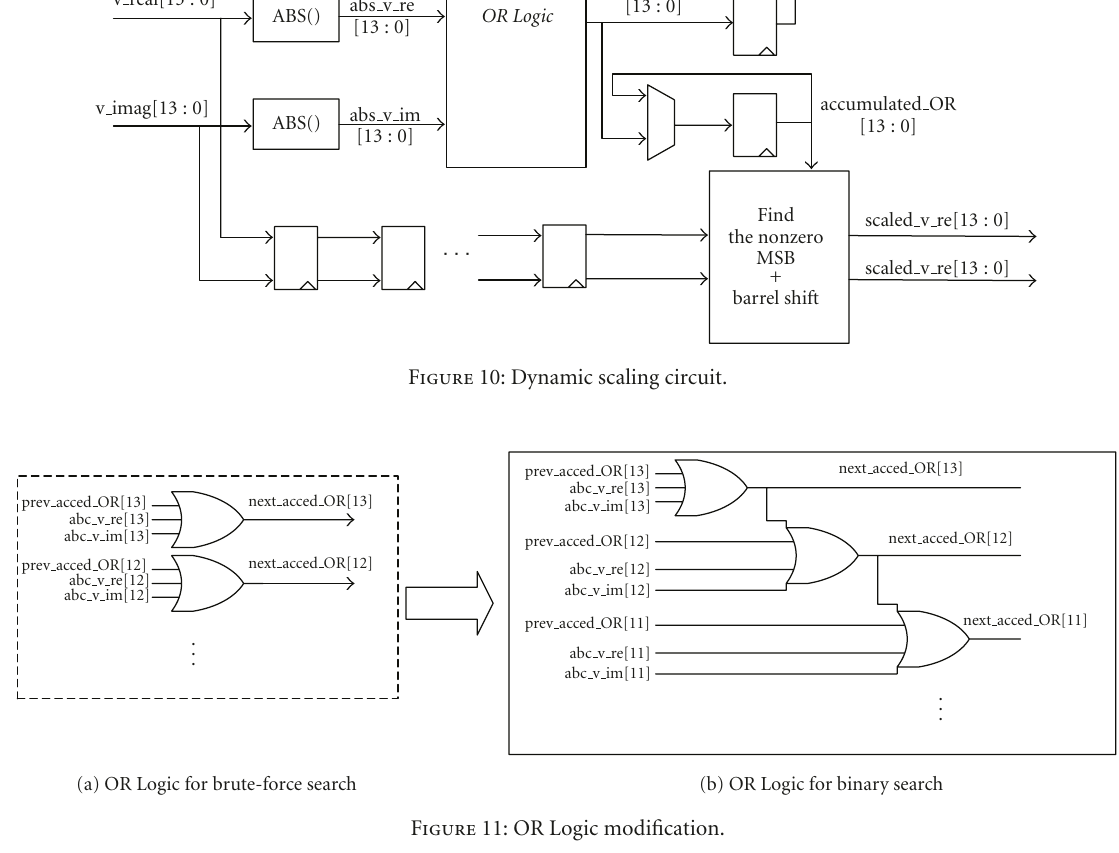
Figure 11: OR Logic modification.